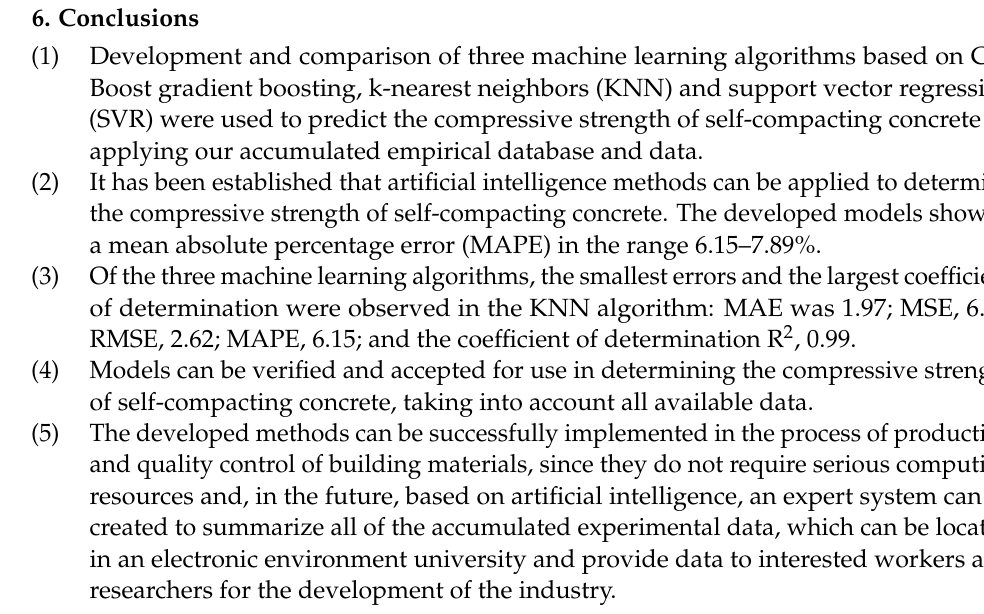
Figure 9. Metric values for the developed regression models: ( a ) MAE; ( b ) MSE; ( d ) RMSE; ( c )